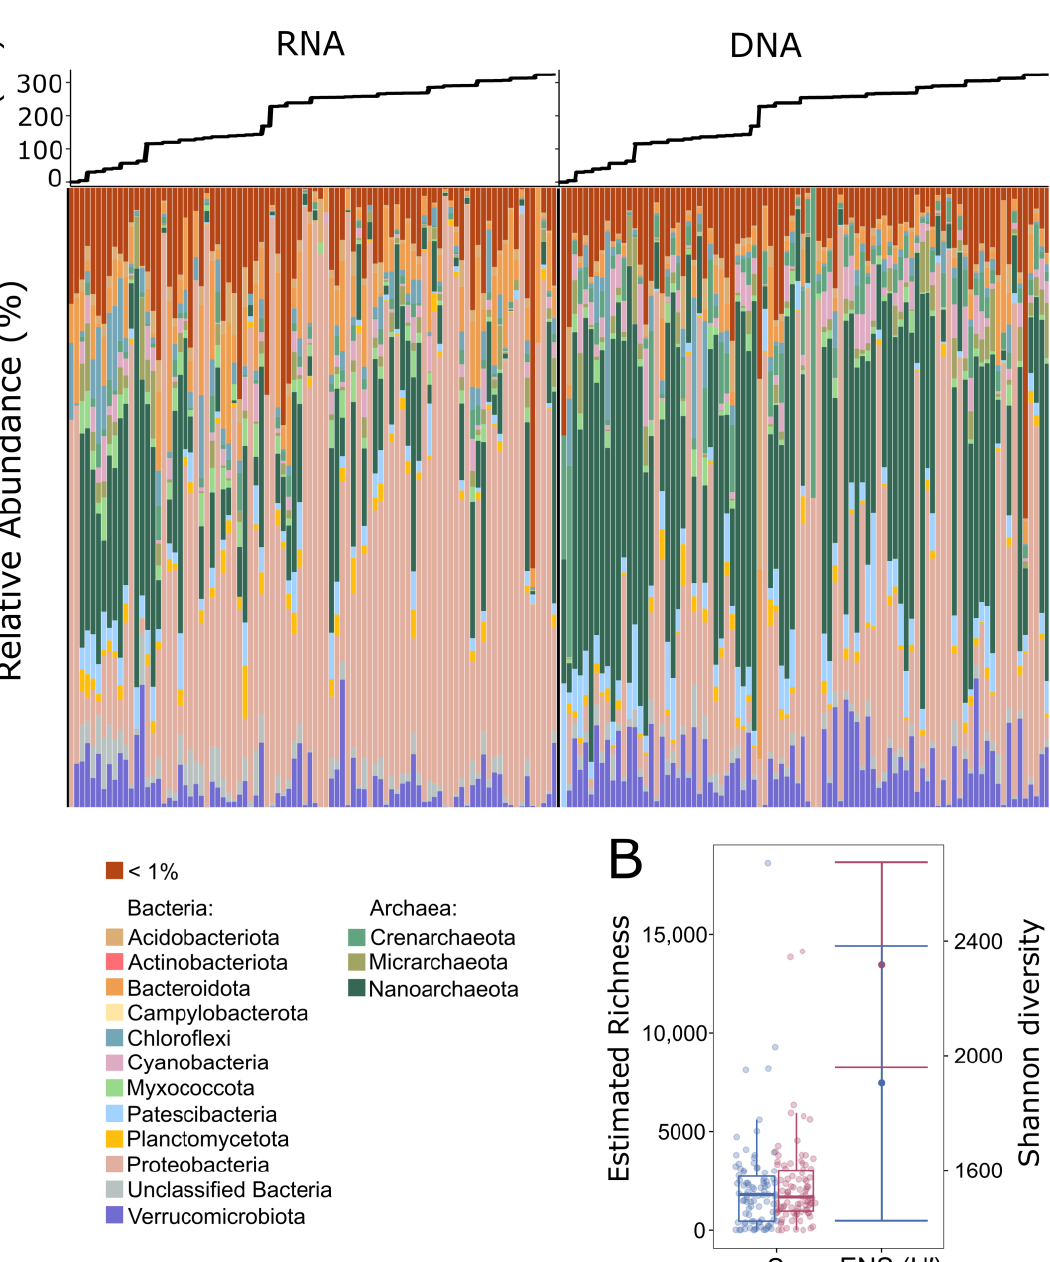
Figure 4. ( A ) Relative abundance plot of total, and active fractions of groundwater prokaryotic communities. Samples were ordered according to their distance to the source of the Mur River, where the source itself is on the far-left side of the plot. ( B ) Total richness estimates (S) are plotted in a boxplot showing differences in RNA (blue)- and DNA (red)-derived communities, as well as covariate-wise mean estimates of DNA- and RNA-derived communities of the Shannon diversity (ENS ( H′ )) showing error bars as error of the mean.